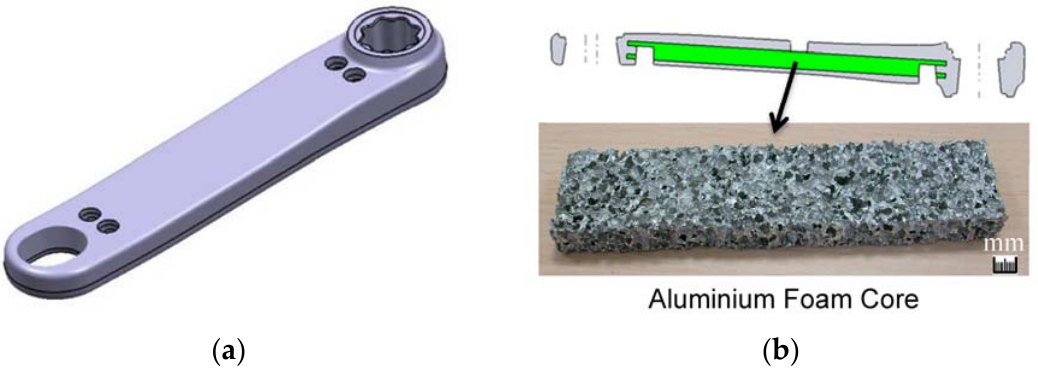
Figure 2. ( a ) 3D rod design; and ( b ) detail of the placement and example of an aluminium foam core.